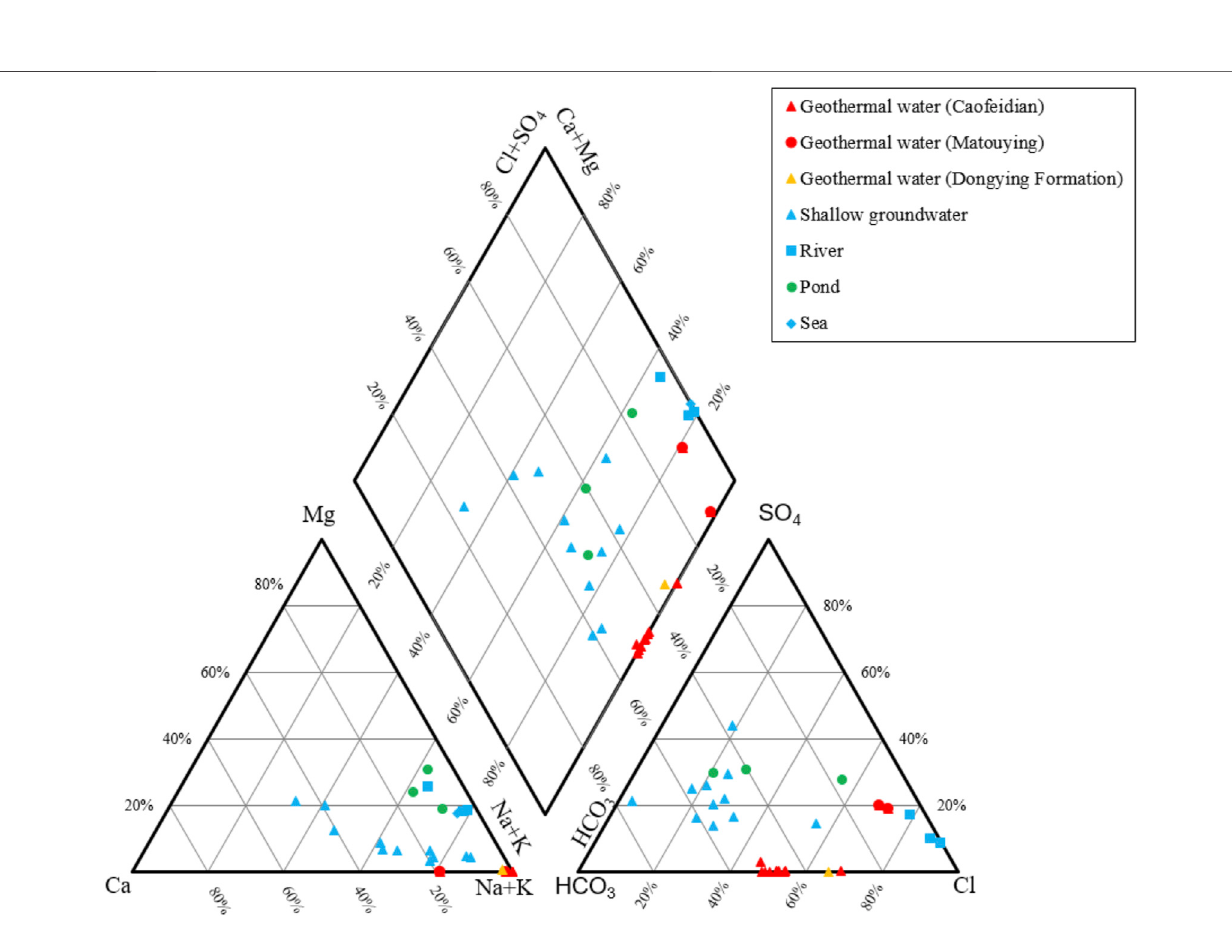
Frontiers in Earth Science |